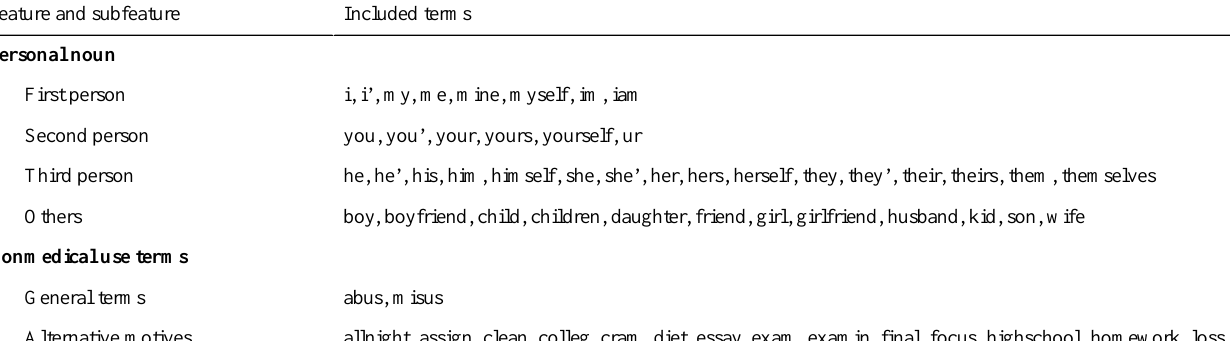
Table 1. Features for supervised learning.